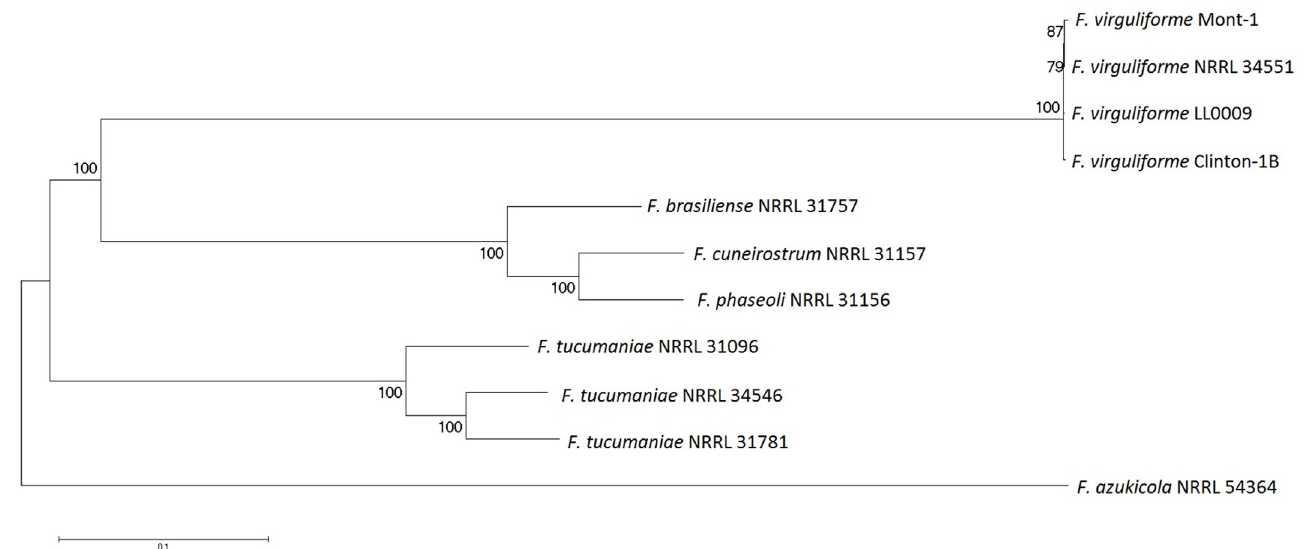
Fig 2. Maximum-likelihood midpoint rooted tree of 11 SDS/BRR Fusarium isolates, inferred from genome-wide SNP data with 200 bootstrap samples.